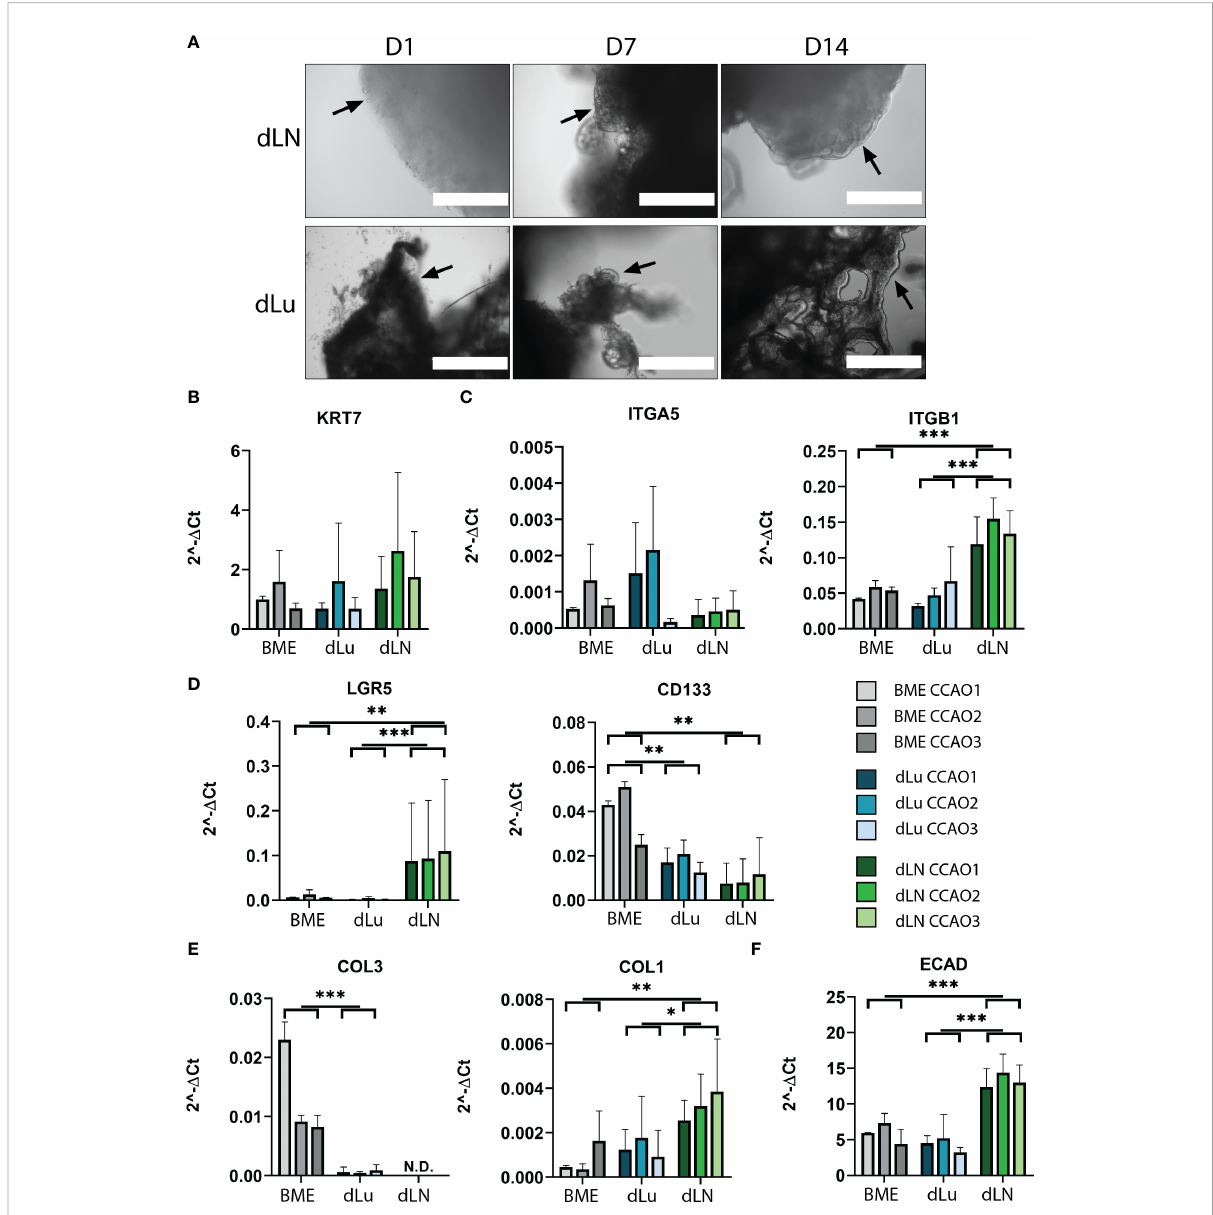
FIGURE 5 Recellularization of dLu and dLN with CCAOs reveals distinct gene expression pro fi les. (A) Representative bright fi eld microscopy images of CCAOs cultured in dLu and dLN on day 1, 7 and 14 after recellularization. Day 1 scale bar indicates 1000 µ m, day 7 and day 14 scale bars indicate 400 µ m. Black arrows indicate the progression from single cells at day 1 to a complete cellular layer at day 14. (B) Gene expression of KRT7 in CCAOs for BME control and recellularized dLu and dLN. (C) Gene expression of ITGA5 and ITGB1 in CCAOs for BME control and recellularized dLu and dLN. (D) Gene expression of LGR5 and CD133 in CCAOs for BME control and recellularized dLu and dLN. (E) Gene expression of COL3A1 and COL1A1 in CCAOs for BME control and recellularized dLu and dLN. (F) Gene expression of ECAD in CCAOs for BME control and recellularized dLu and dLN. * = p-value < 0.05, ** = p-value < 0.005, *** = p-value < 0.0001. N.D. means that the values were not detectable. Mann-Whitney U statistical test was used for determining signi fi cance in gene expression pro fi les. All gene expression pro fi les were normalized to GAPDH. For recellularization experiments